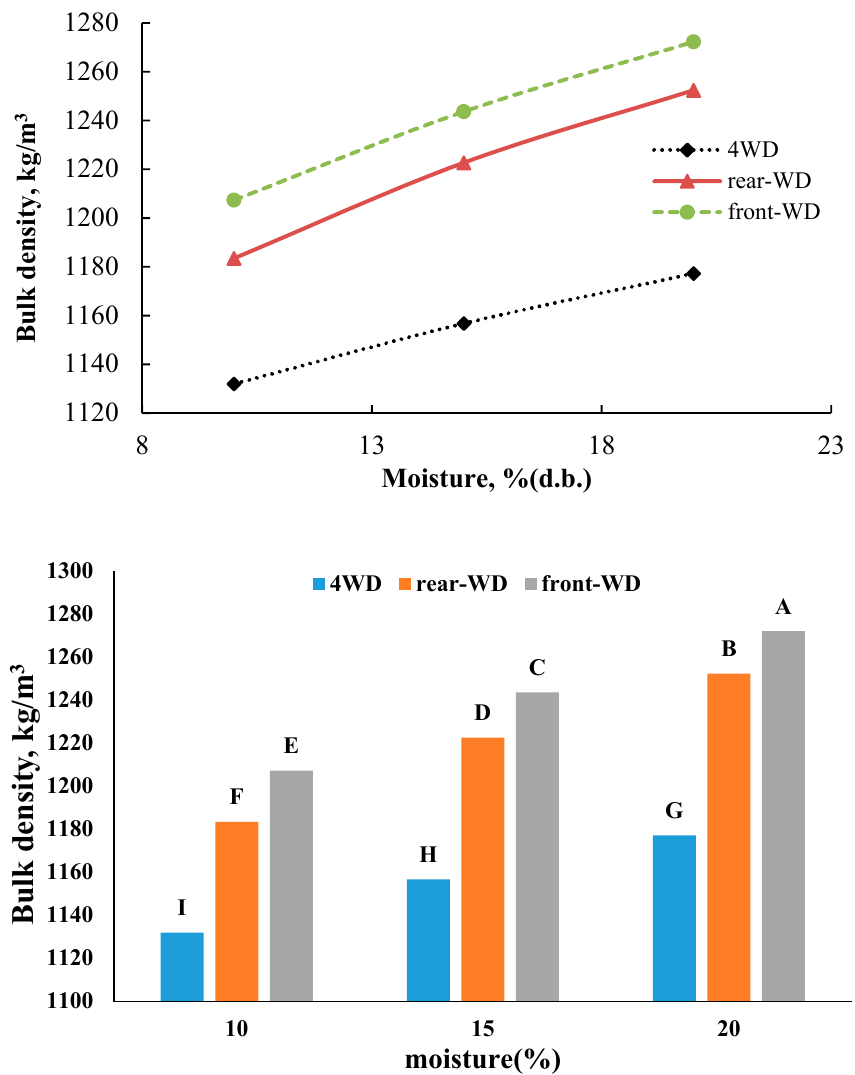
Figure 5. Effects of the drive system on soil compaction at three soil moisture contents cores (different letters shows significant difference between treatments).